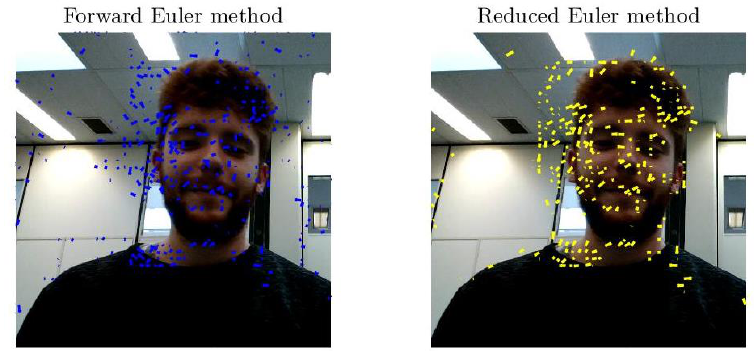
Figure 8. Results of optical-flow estimation when the windows size was set to 15 ×